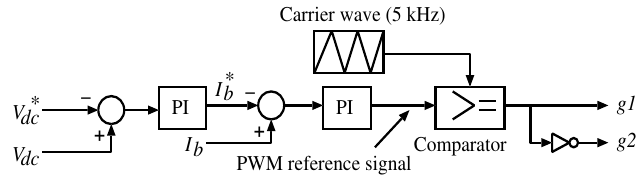
Figure 8. Constant DC bus voltage control system for fault condition.